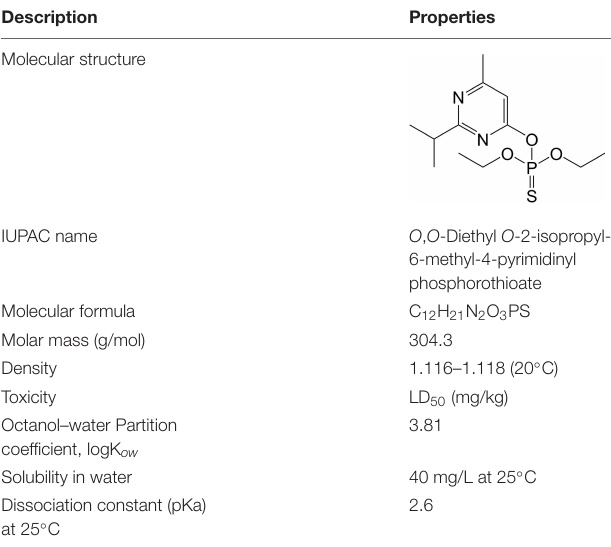
TABLE 1 | Physical and chemical properties and structure of diazinon (Malakootian et al., 2020).